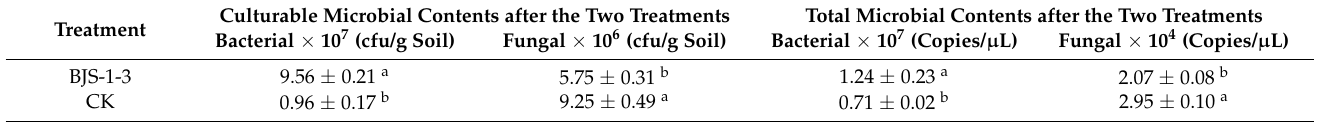
Table 3. Microbial quantity in rhizosphere soils of both